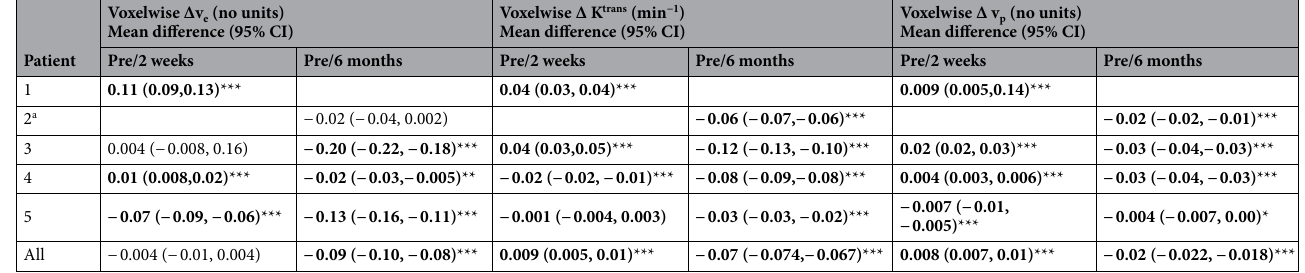
Table 4. Voxelwise temporal changes in tumour DCE-MRI derived microvascular parameters. Statistically significant values ( p ≤ 0.05) are shown in bold P value calculated using repeated measures ANOVA or repeated measures mixed-effects model. Post hoc analysis of pairwise comparisons between different timepoints was performed using the Bonferroni method. ***≤ 0.001; **≤ 0.01; *≤ 0.05. a Difference between post-treatment timepoints shown as no pre-treatment imaging dataset.